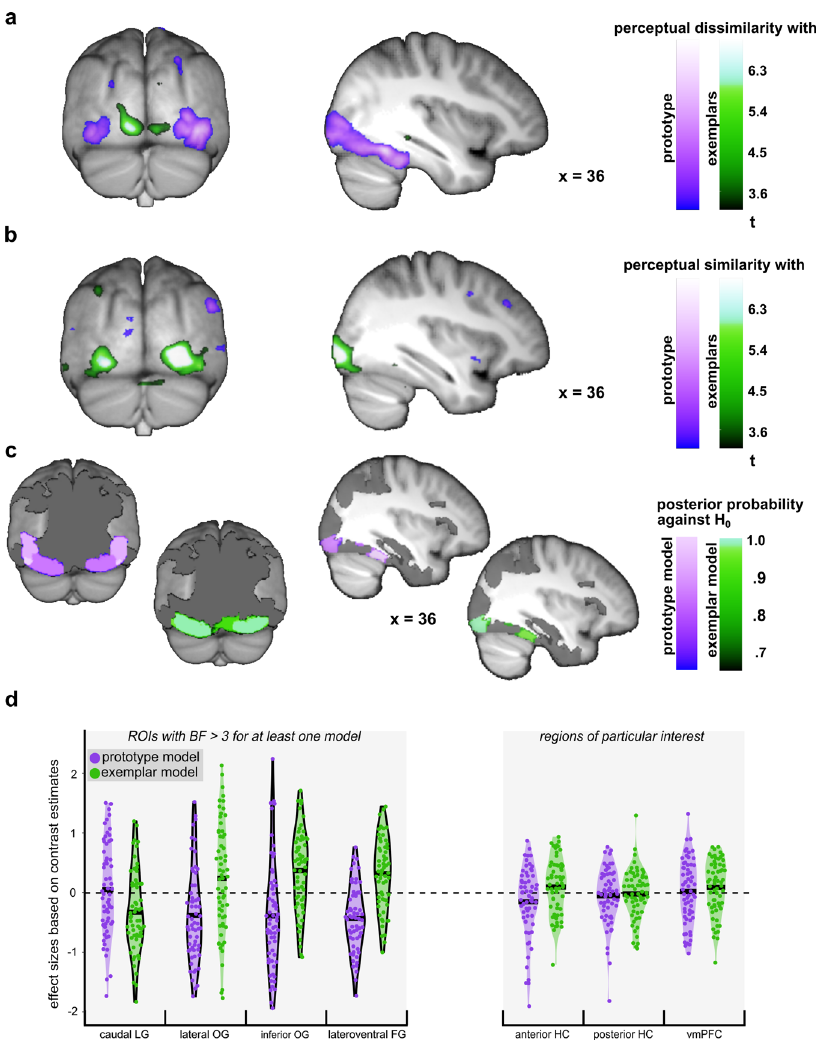
Fig. 2 Univariate prototype and exemplar representations ( n = 62 individuals). a Negative correlation with perceptual similarity (i.e. perceptual distance). Regions sensitive to model-based perceptual distances to the prototype (purple) and to exemplars (green). A search depth of 16 voxels was applied to also depict exemplar model representations located slightly below the cortical surface. b Positive correlation with a perceptual similarity. Regions sensitive to model-based similarities to the prototype (purple) and to exemplars (green). a , b Statistical t -maps are thresholded at p unc < 0.001 for visualisation. c ROI-speci fi c posterior probabilities that univariate effect sizes (ES univ ) for prototype (purple) and exemplar (green) representations deviate from zero. Only ROIs with a BF > 3 for the comparison against the null model are depicted. d Violin plots of observed ES univ for ROIs with a BF >3 for the comparison against the null model and regions of particular interest. The bolded horizontal lines depict the mean ES within each ROI. Black borders around the violin plots highlight effects with a BF >